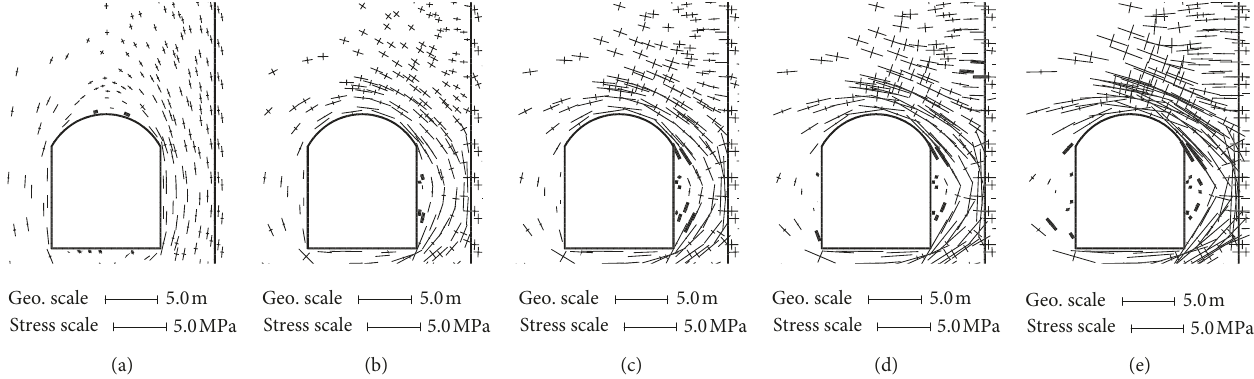
Figure 12: Stress fields under different lateral stress coefficients: (a) k